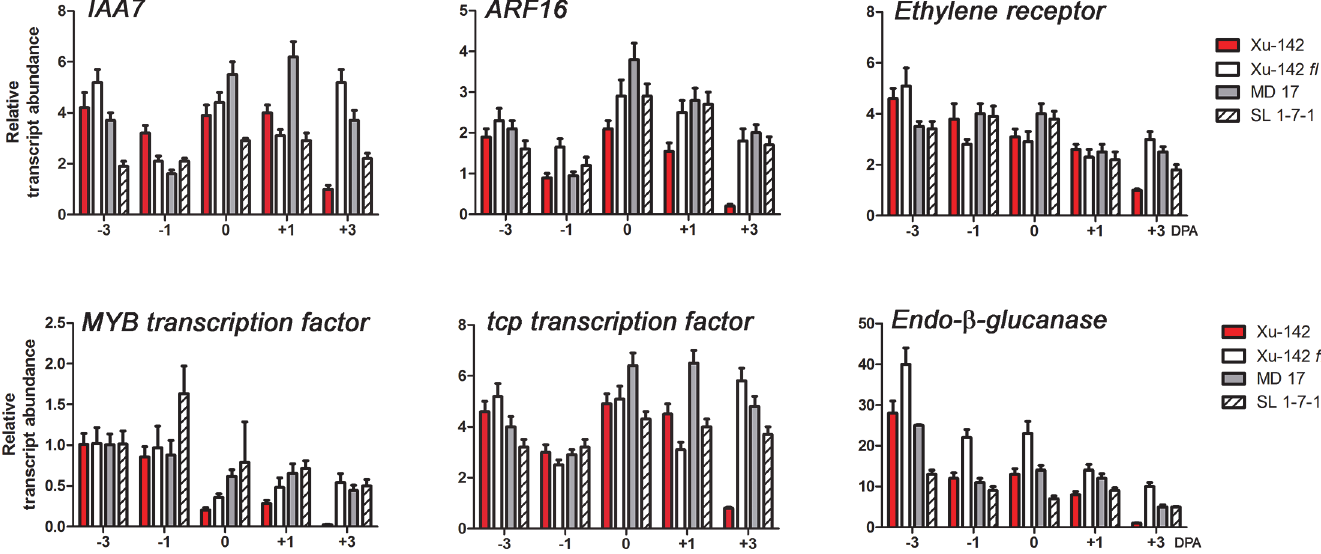
Fig 7. Expression patterns of Class 2 DEGs, genes more highly expressed in fiberless mutant ovules than wild type ovules at 3DPA. Transcript levels were measured by RT-qPCR from a WT (Xu-142) and three fiberless mutants (Xu-142 fl , MD 17, and SL 1-7-1) that were harvested on -3, -1, 0, 1, and 3 DPA. IAA7 (Gorai.009G132200), ARF16 (Gorai.011G238900), ethylene receptor (Gorai.002G038300), MYB transcription factor (Gorai.013G196800), tcp transcription factor (Gorai.012G166500), and Endo- β -glucanase (Gorai.007G126900). All RT-qPCR analyses were performed with three biological replications at each time point with five technical replications. The error bars represent